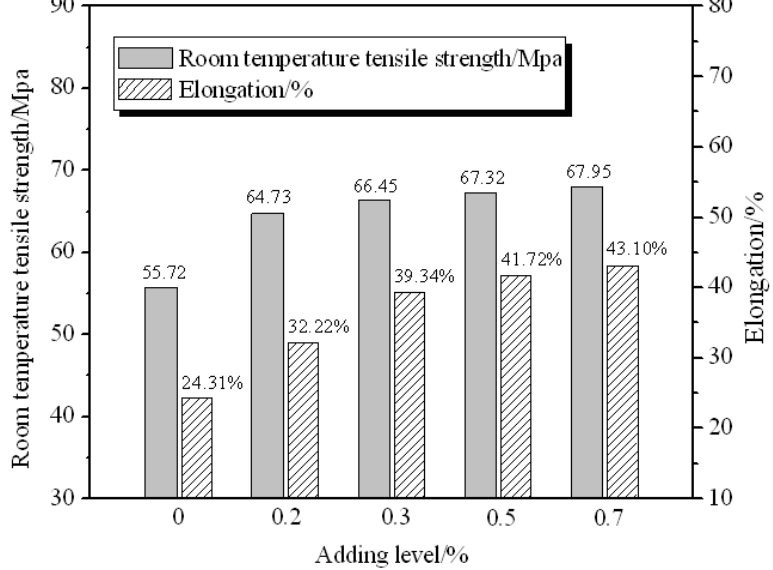
Figure 11. Tensile properties of commercial pure aluminum with different adding levels of Al-5Ti-0.62C-0.2Ce master alloy.